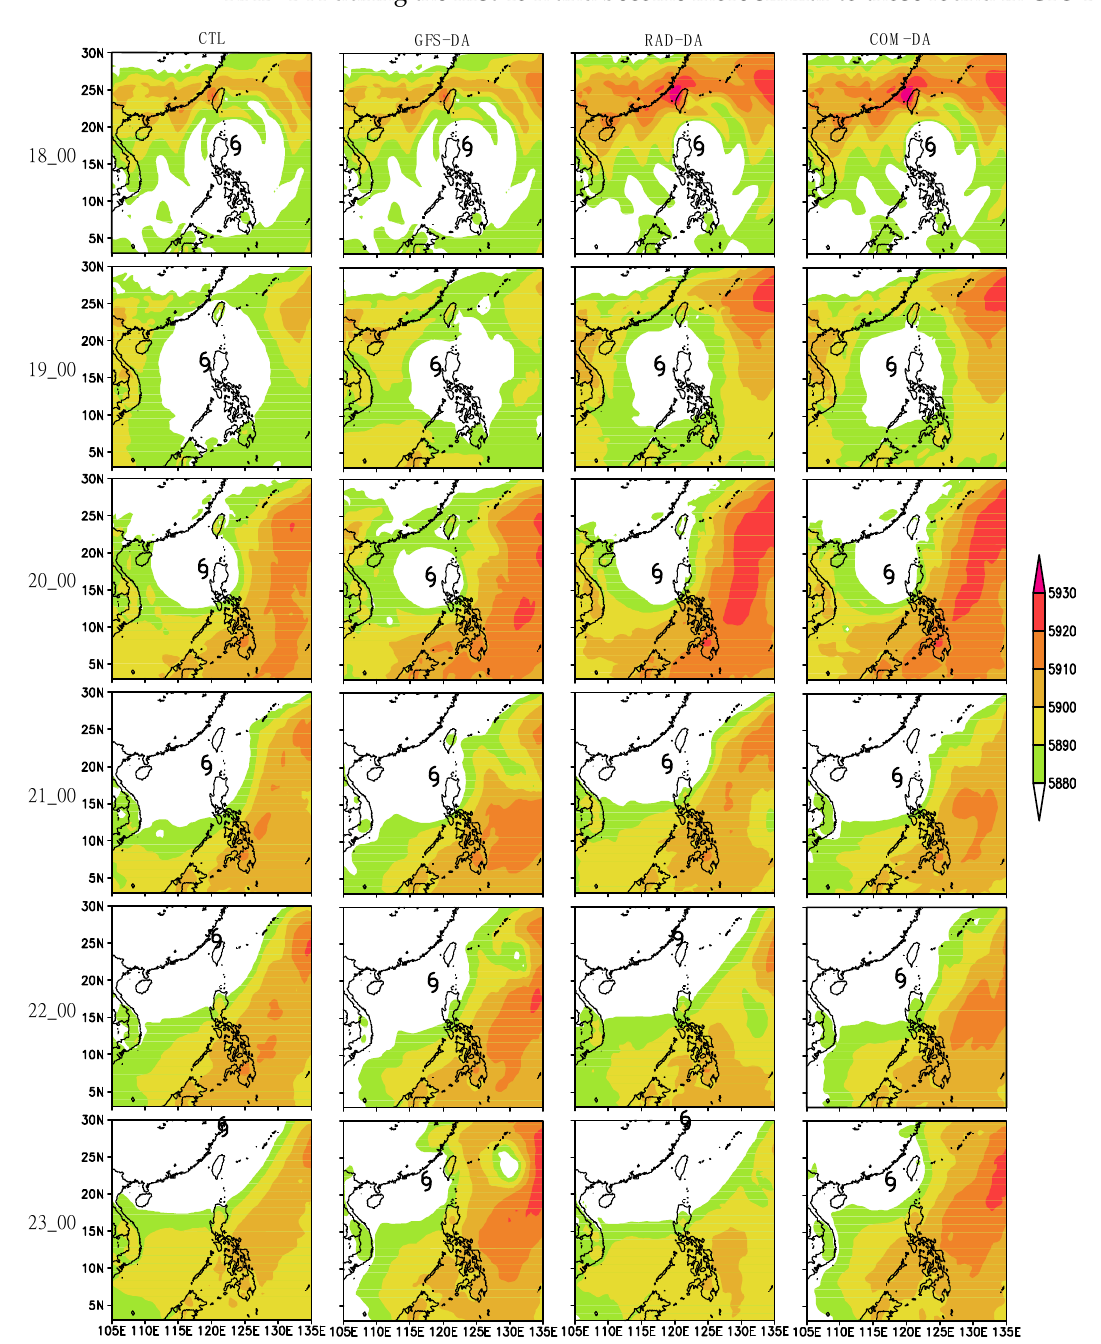
Figure 9. Geopotential heights (unit: gpm) at 500 hPa, valid at 0000 UTC of 18–23 Oct 2010 for experiments CTL, RAD ‐ DA, GFS ‐ DA, and COM ‐ DA.